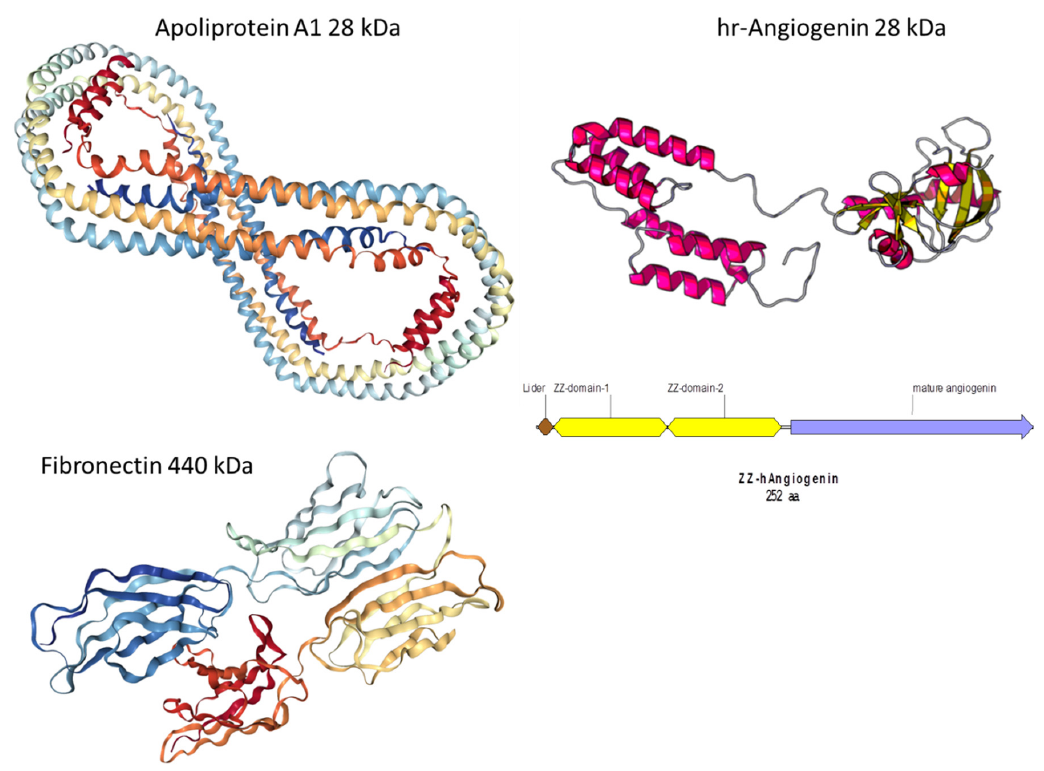
Figure 9. The structure of Fibronectin(FN), human recombinant Angiogenin (hrANG), and Apoliproprotein Apo-A1.